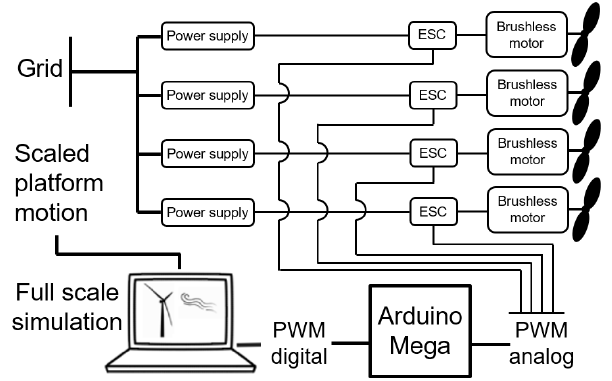
Figure 2. SiL control diagram (Vittori et al.,